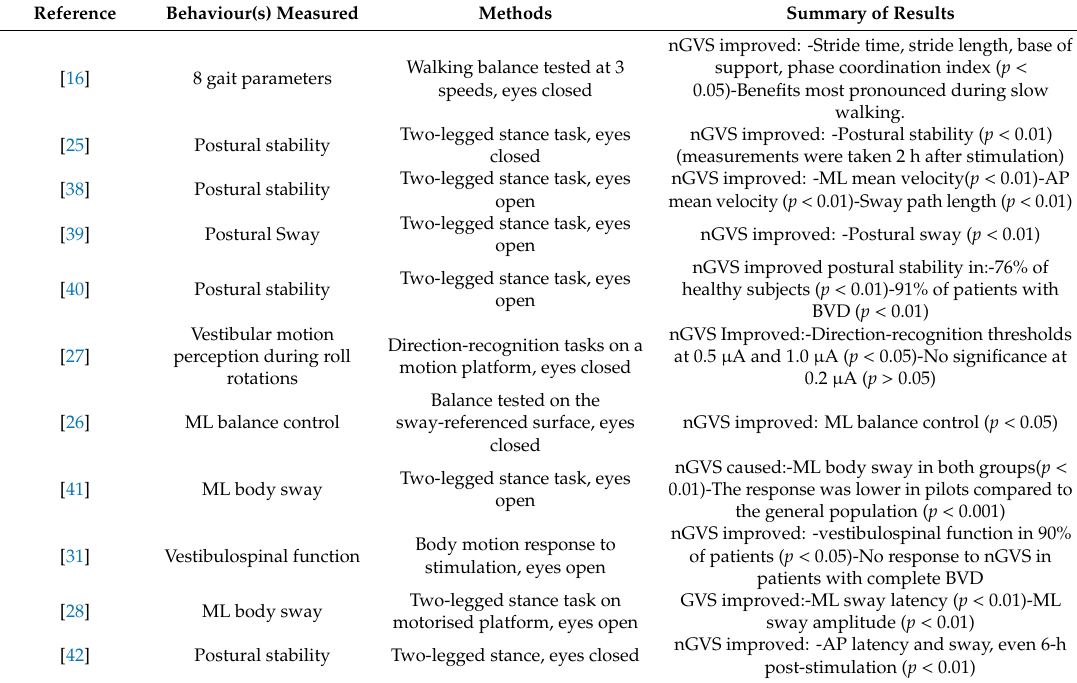
Table1. Asummaryofthemeasuredbehaviours, methodsandresultsofthereviewedpublishedstudies.